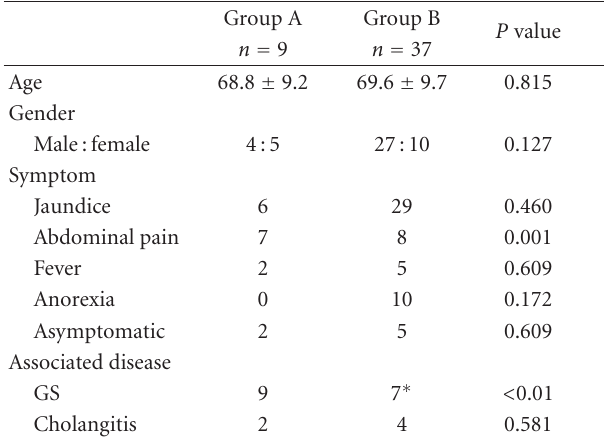
Table 1: Patient